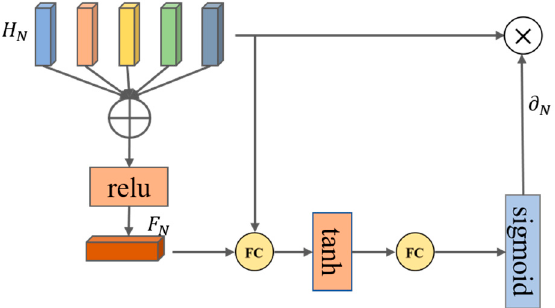
Figure 5. Illustration of the spatial attention network. We firstly aggregated the vector H N ∈ R 512 × 5 of all IMUs as a query feature F N ∈ R 512 , then calculated the attention scores of all IMUs ∂ N ∈ R 5 . We used the non-linear function of Sigmoid due to the possibility of multiple key joints. The output of this network is a 5 × 512 -dimensional